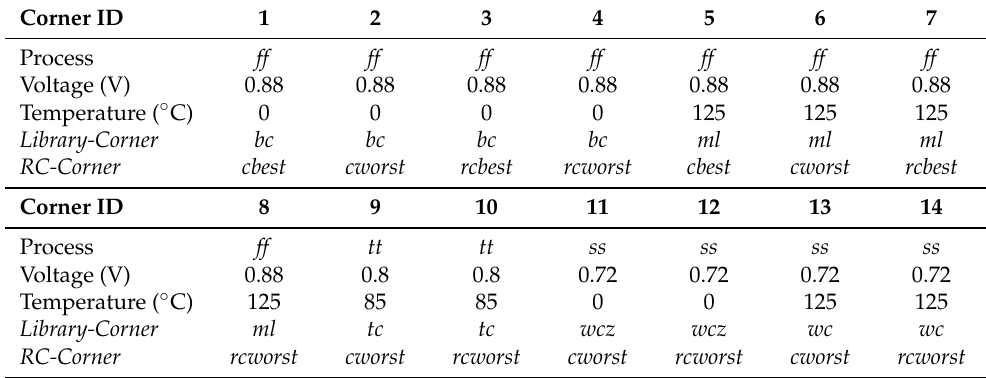
Figure 1. Prediction accuracy distribution for art1 . Each point represents a dominant corner com- bination. The abscissa value is the ID of the combination, and the ordinate value is the prediction accuracy corresponding to the combination. The maximum accuracy, minimum accuracy, and the difference between the two are all marked. Table 1. Parameter Value of